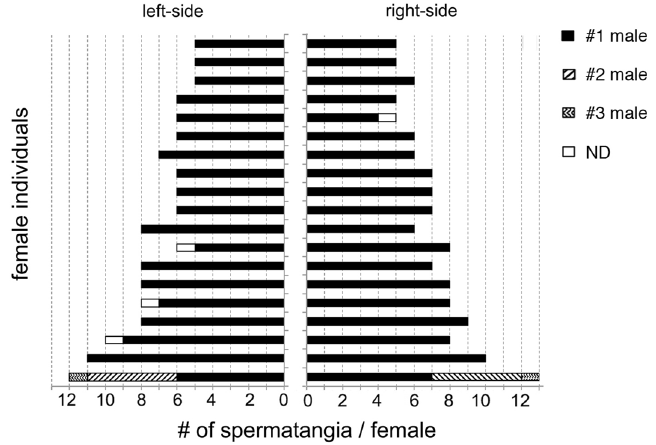
Figure 2. Paternity analysis of each spermatangium stored on the females. Using a total of nineteen females, every single spermatangium was isolated and genotyped. Each column represents paternity share by the first ( filled box ), second ( diagonal stripes ) and third ( jagged stripes ) male. Open box indicates unidentified